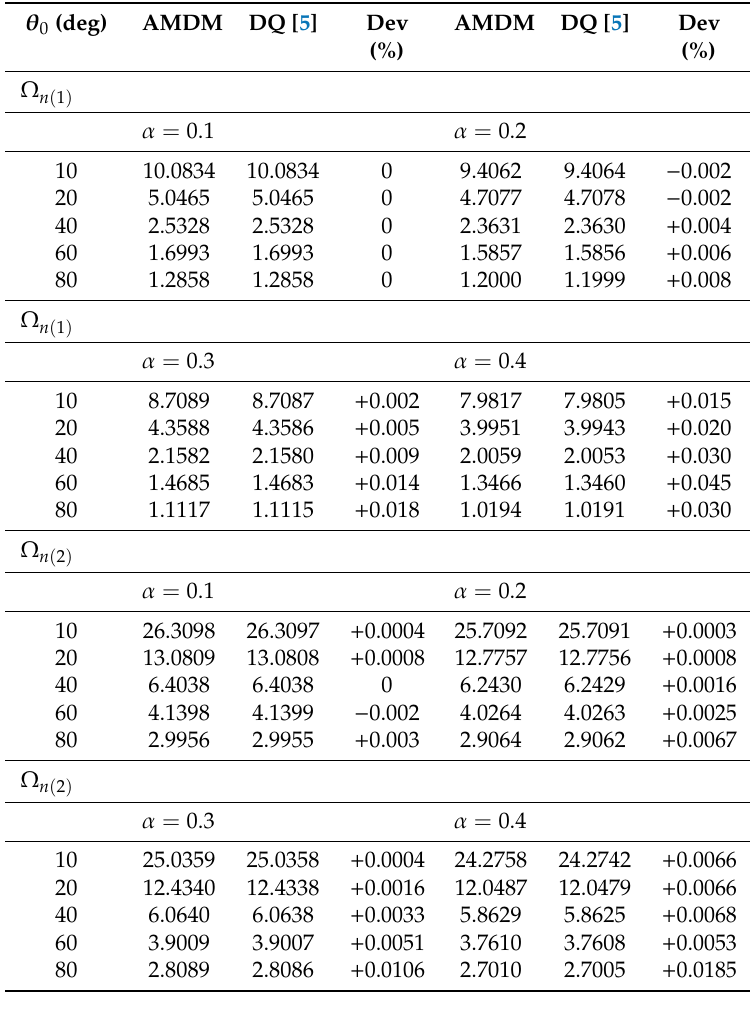
Nondimensional natural frequencies for a nonrotating arch under clamped-free boundary